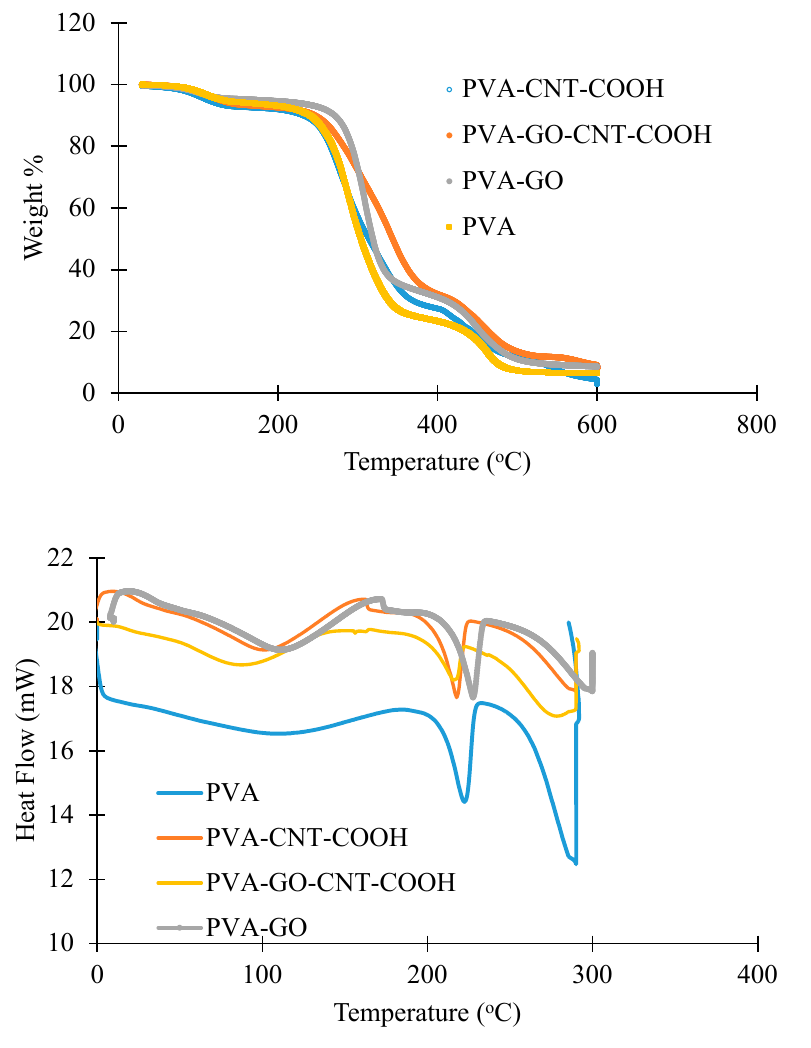
Figure 4. TGA and DSC curves of PVA and nanomaterial based PVA membranes.